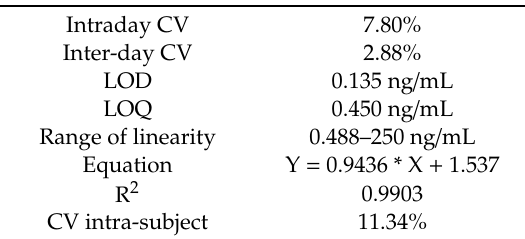
Table 2. Validation parameters.